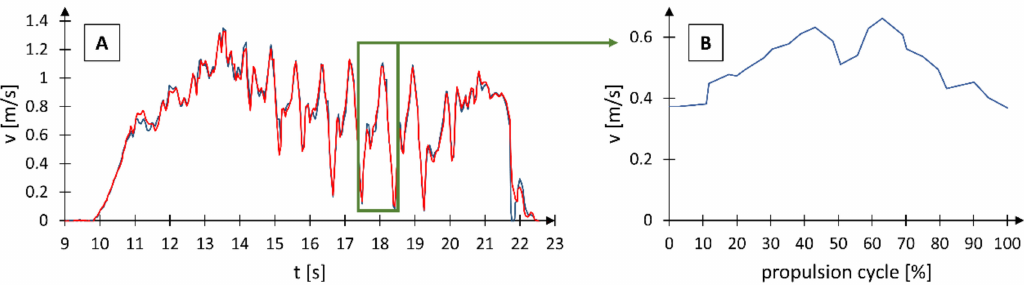
Figure 4. The example of the wheelchair velocity diagram during slope climbing ( A ) and a separated single propelling cycle in the function of the percentage value of the propelling cycle completion ( B ). Given the wheelchair linear velocity 𝑣(𝑡) for a single propelling cycle, firstly, the path distance was defined 𝑠 (cid:3004) (1) and the wheelchair total acceleration 𝑎 (cid:3021) (2). Based on the defined acceleration 𝑎 (cid:3021) the propelling force 𝐹 (cid:3005) (3) of the whole wheelchair was calculated. Given the propelling force 𝐹 (cid:3005)